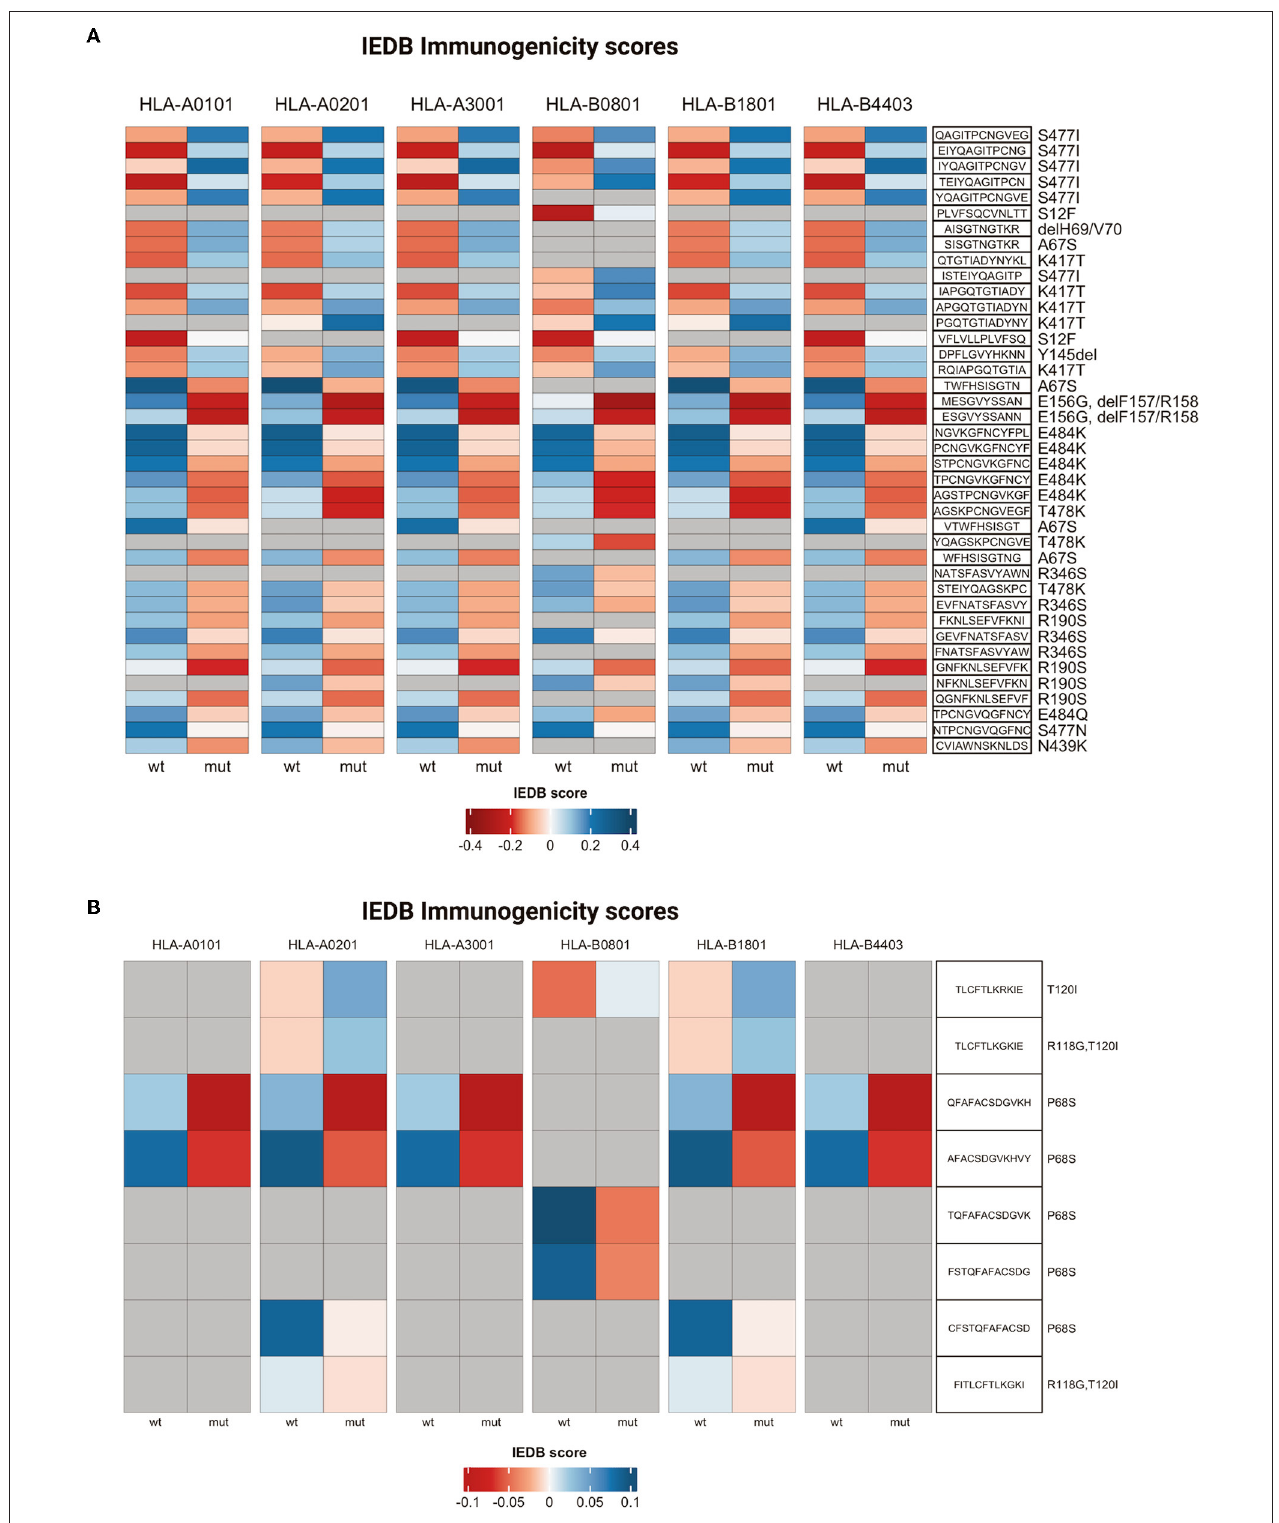
FIGURE 9 | T cell immunogenicity analysis. Heatmaps representing T cell immunogenicity scores for wild-type and mutated peptides from Spike (A) or ORF7a (B) . IEDB scores range from dark red (low immunogenicity) to blue (high immunogenicity).